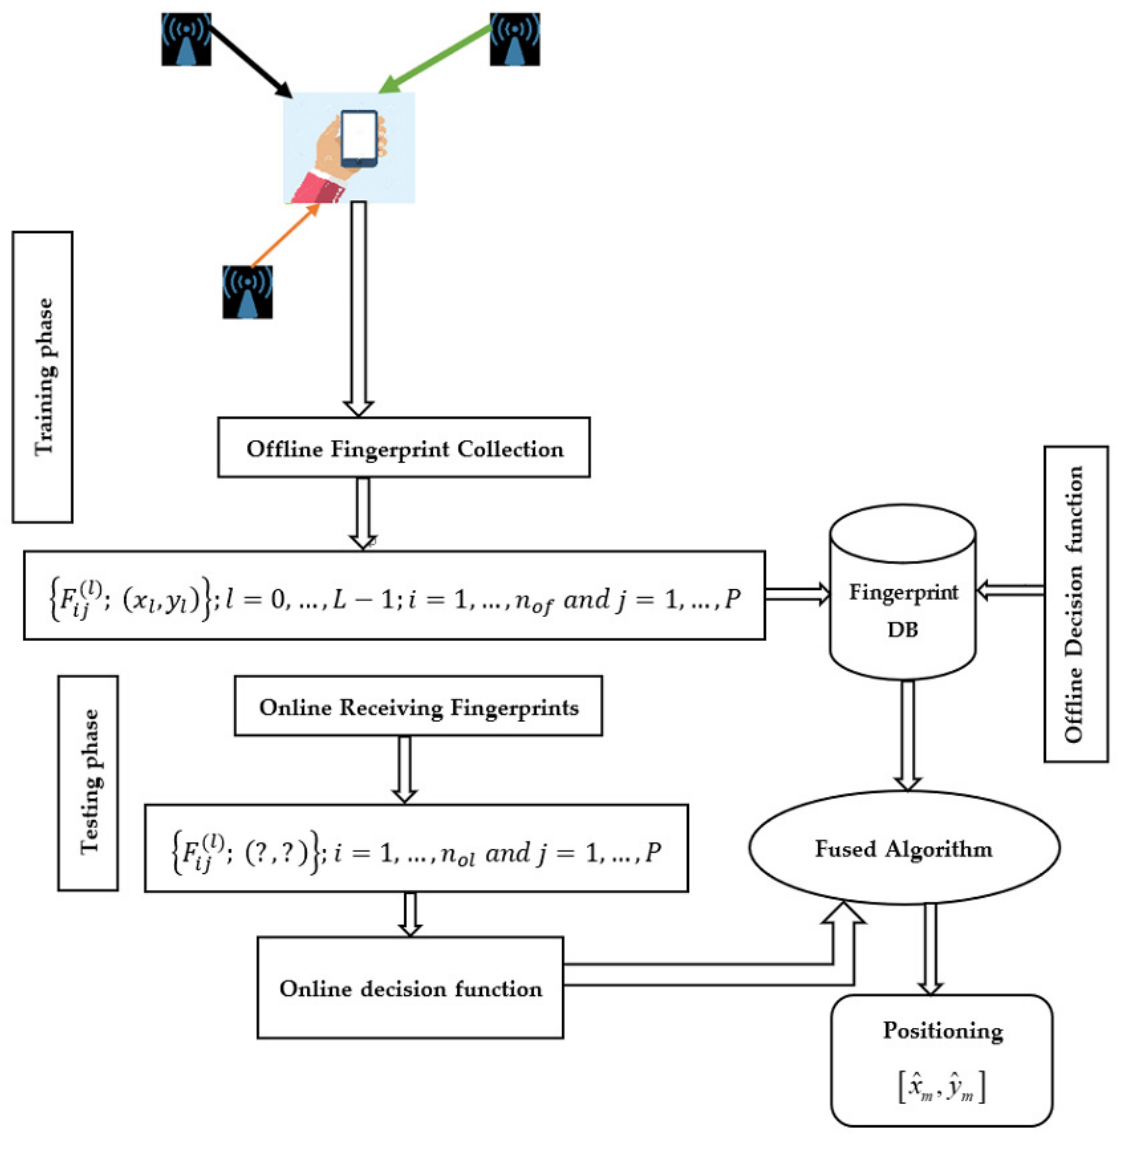
Figure 1. System Operation for RSS-based Fingerprinting of Indoor Positioning System.